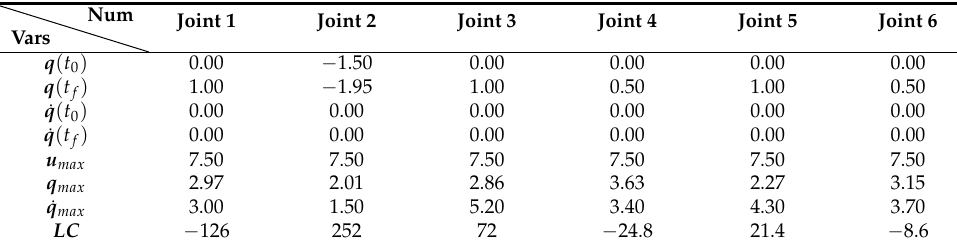
Table A2. The OCP constraint conditions of the Manutec R3 Model 1.